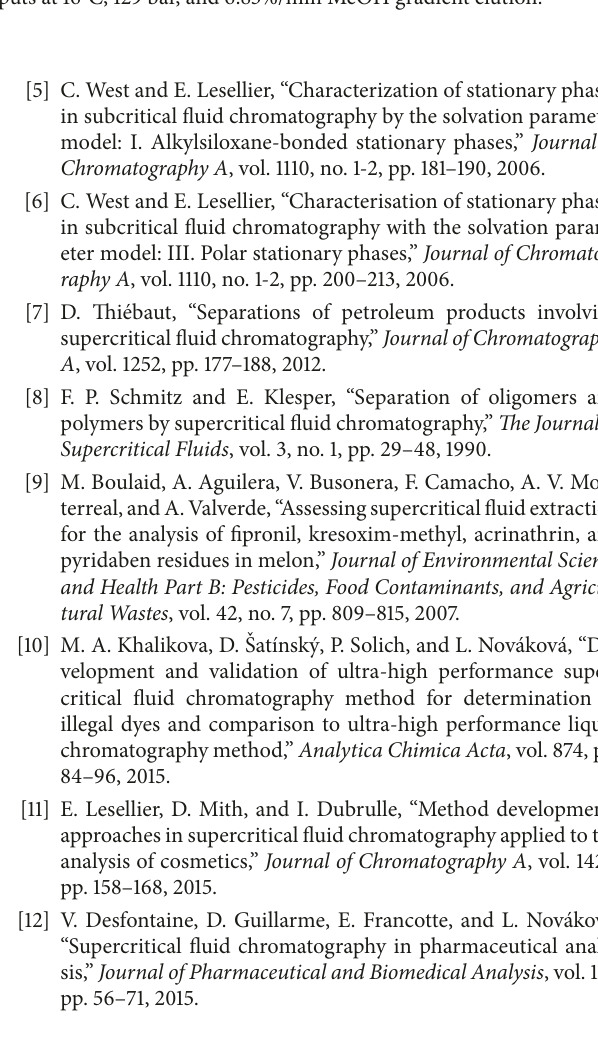
Figure 9: Recorded chromatograms based on PARAFAC outputs at 16 ∘ C, 129 bar, and 6.83%/min MeOH gradient elution.